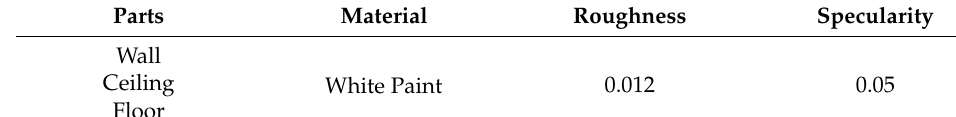
Figure 2. LEED v4.1 daylight option 2 criteria (reconstructed the Daylight evaluation of LEED v4.1 Building Design and Construction).